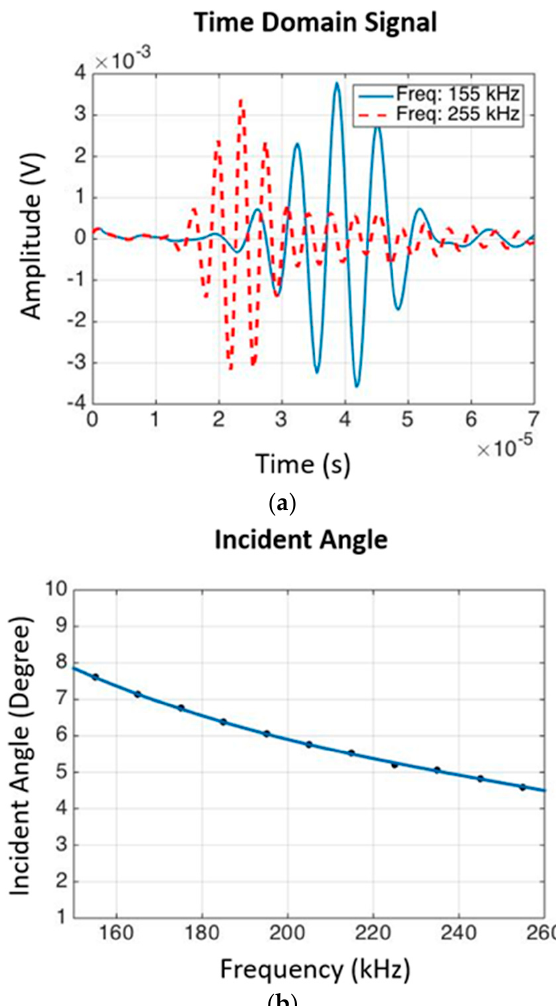
Figure 13. ( a ) Time domain signals of the transmitted anti-symmetric wave. The wave mode with a higher frequency travels with a higher speed; ( b ) Incident angle within the frequency range of interest.